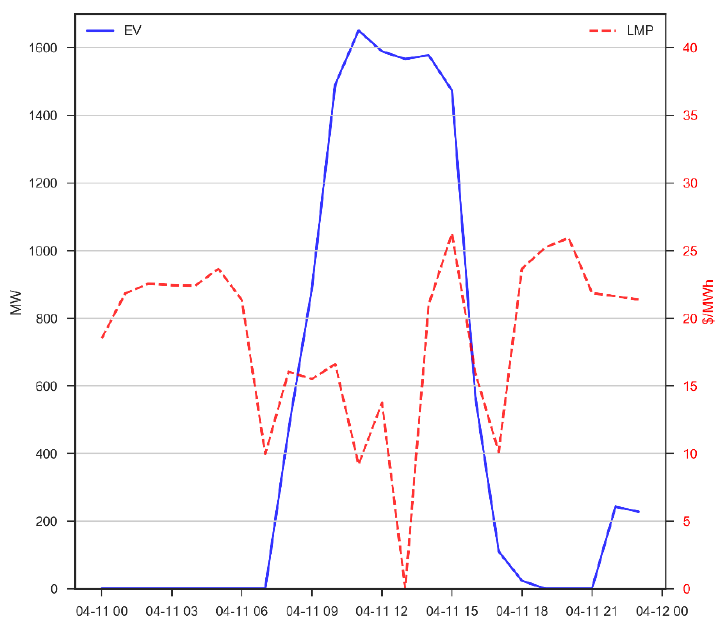
Figure 19. LMP and EV load profiles when employing coordinated EV charging, on a day during Duck week.